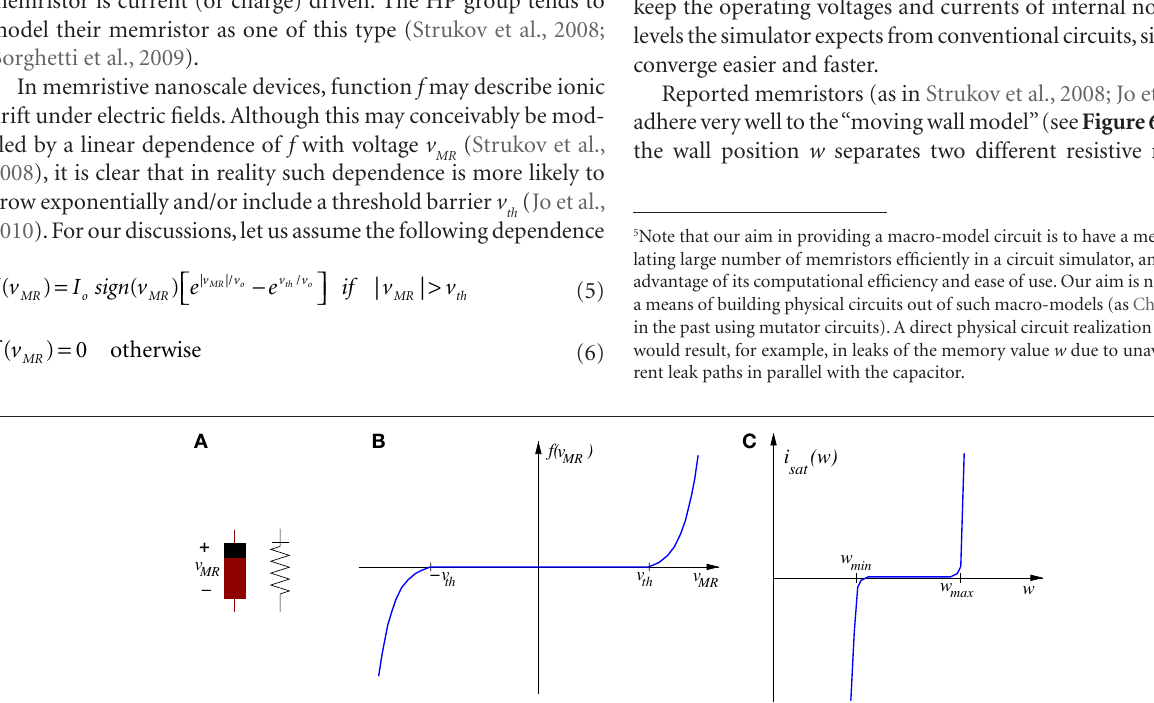
Figure 5 | (A) Memristor asymmetric symbols. (B) Memristor non-linear weight update function with exponential growth and thresholding. (C) Memristor saturation function for limiting range of weight.